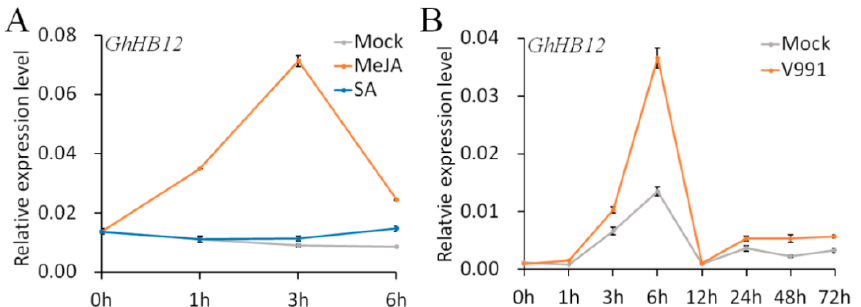
Figure 1. The expression patterns of GhHB12 in response to ( A ) methyl jasmonate (MeJA) and salicylic acid (SA) and ( B ) V. dahliae infection. Total RNAs were extracted from roots of ”YZ1” seedlings at the indicated time points after treatments. The GhUBQ7 gene was used as the endogenous reference gene. The data represent the mean ± SD of three technical replicates.